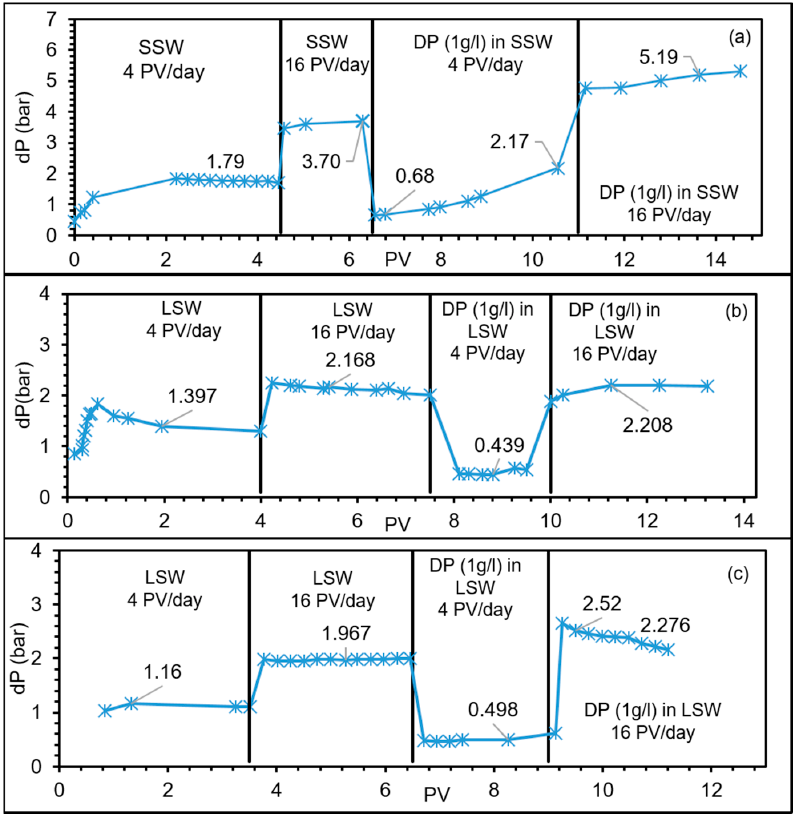
Figure 9. Differential pressure drop (dP) profile for SK5-SSW ( a ), SK6-LSW ( b ) and SK7-mixed ( c ).